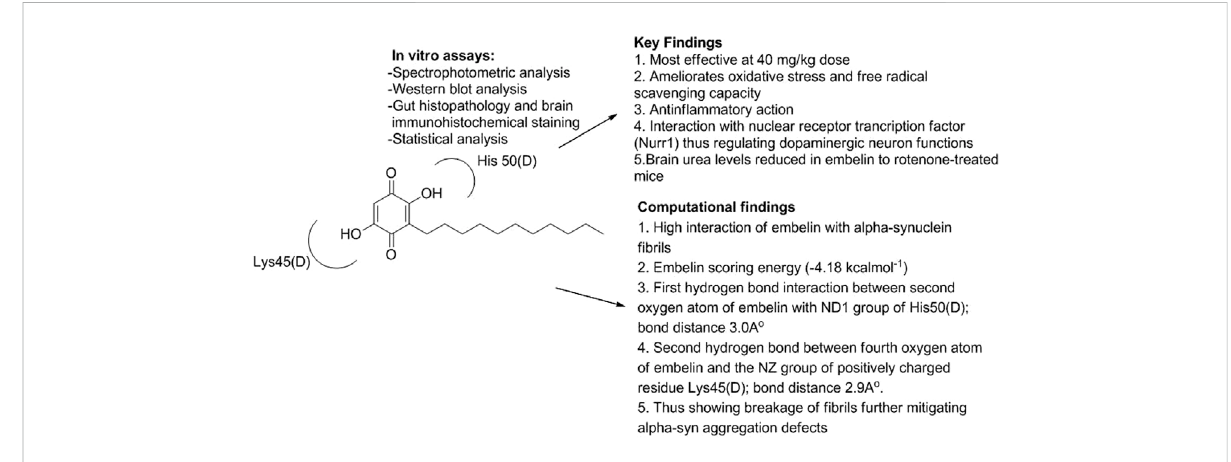
FIGURE 5 Mechanistic study of embelin in PD and Huntington ’ s